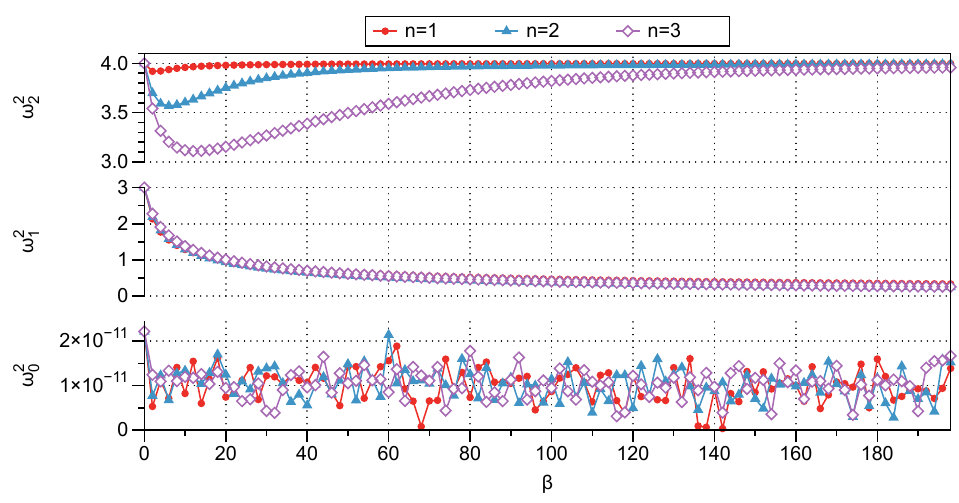
Figure 3 . The eigenvalues of the bound states ! 2 V e(cid:11) ( (cid:12); n ; x ), n = 1 ; 2 ; 3 and (cid:12) 2 [0 : 2 :